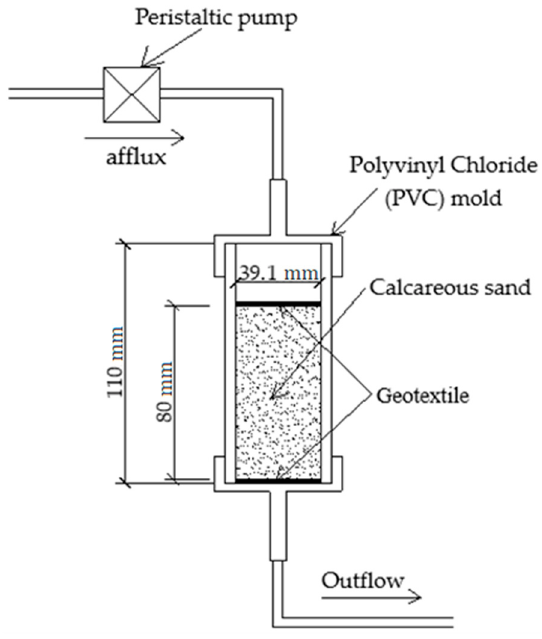
Figure 4. Schematic diagram of the grouting procedure.